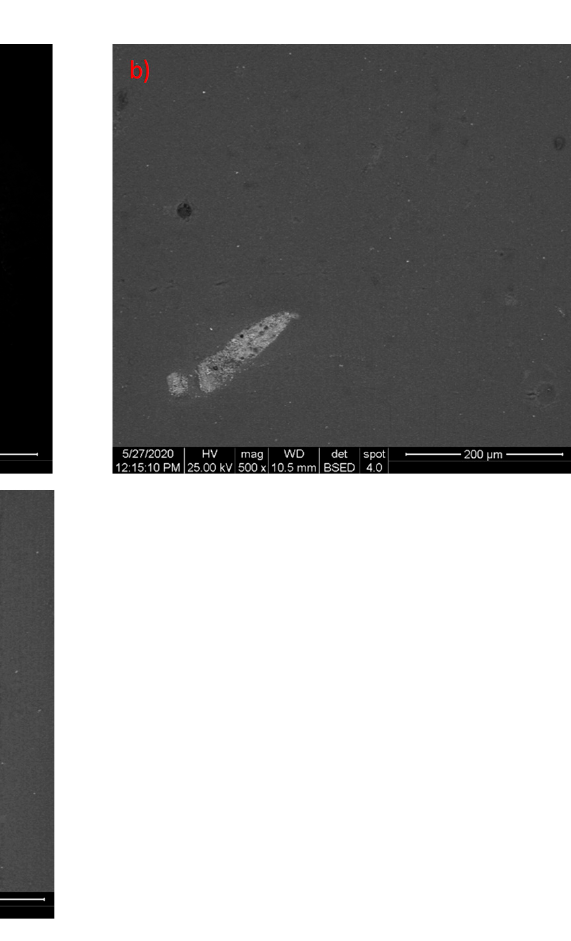
Table 3. Lead–Tin–Antimony-based phases.